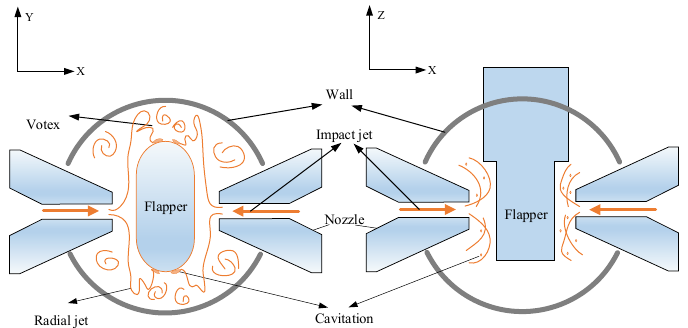
Figure 1. Schematic diagram of the flow field in the pilot stage.